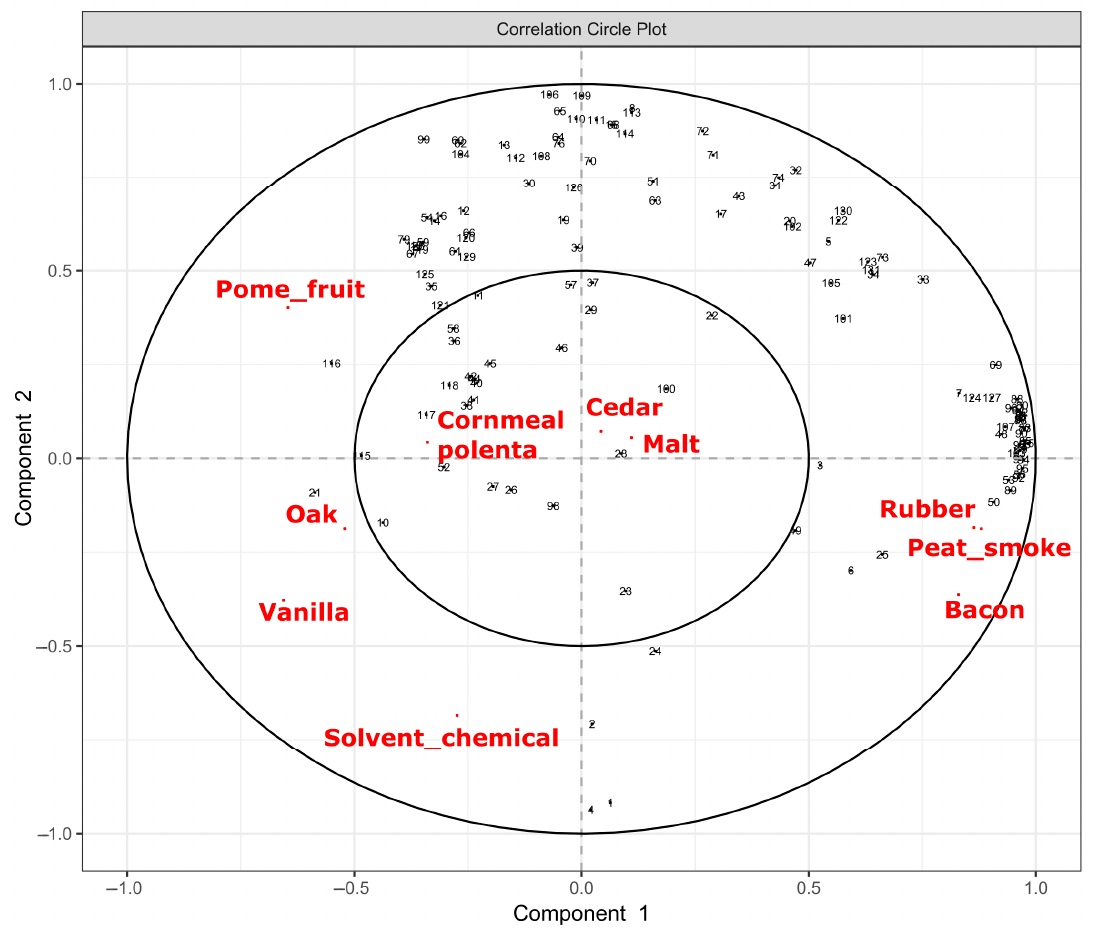
Figure 3. Partial least squares (PLS) variables plot of sensory a tt ributes and their associated chemical compounds. A total of seven sensory attributes were found to be statistically significant (“Sol- vent/Chemical”, “Vanilla”, “Oak”, “Pome Fruit”, “Peat Smoke”, “Bacon”, and “Rubber”) while three were not (“Cedar”, “Malt”, and “Cornmeal/Polenta”). Of the ten descriptors, seven had signi fi cant associations with chemical pro fi ling (“Pome fruit”, “Oak”, “Vanilla”, “Solvent/Chemical”, “Bacon”, “Rubber”, and “Peat smoke”) while three did not (“Cornmeal/polenta”, “Cedar”, and “Malt”). This mostly